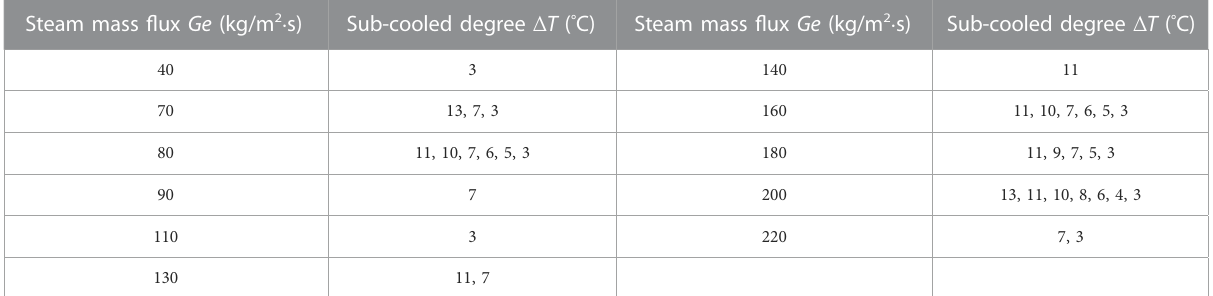
TABLE 2 Experimental